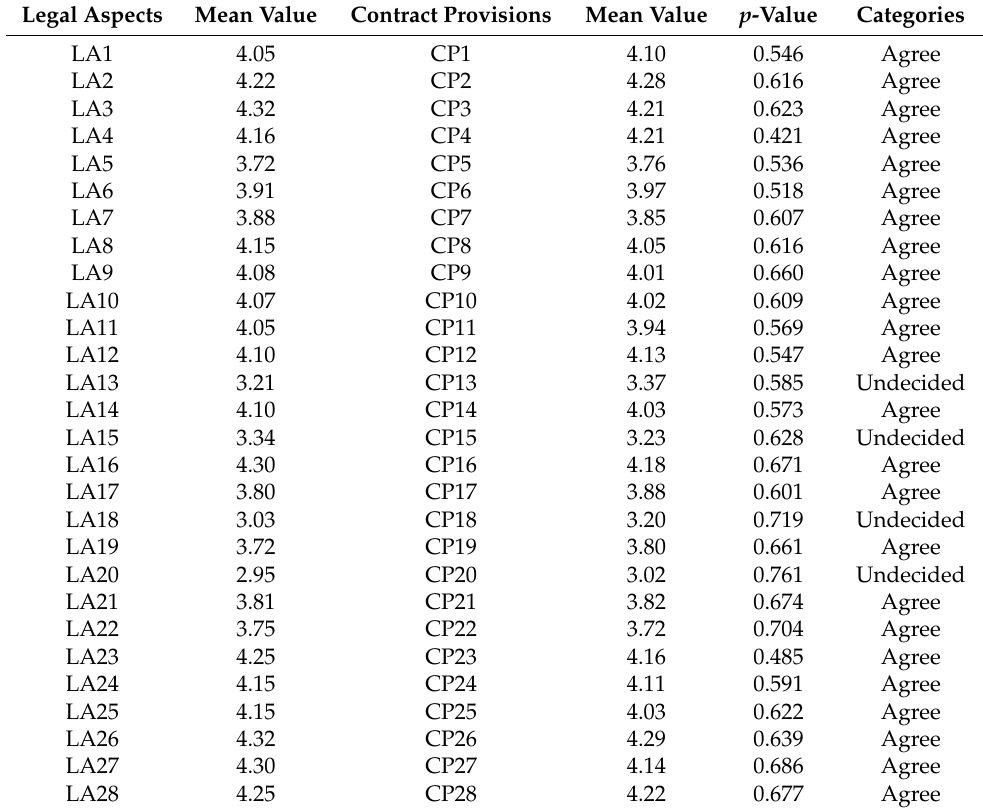
Table 5. Analyzed variables of legal aspects/contract